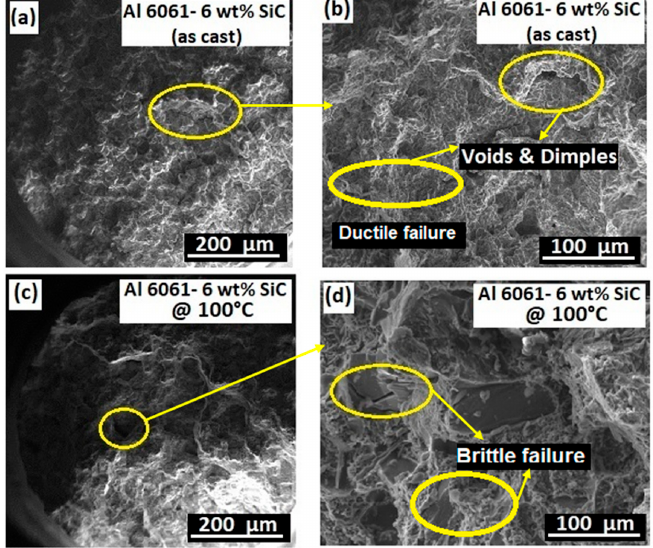
Figure 10. SEM fractographs of as-cast ( a ) Al6061-6 wt.%. SiC composite ( b ) at higher magnification. ( c ) Al6061-6 wt.% SiC composite peak-aged at 100 ◦ C. ( d ) Different locations at higher